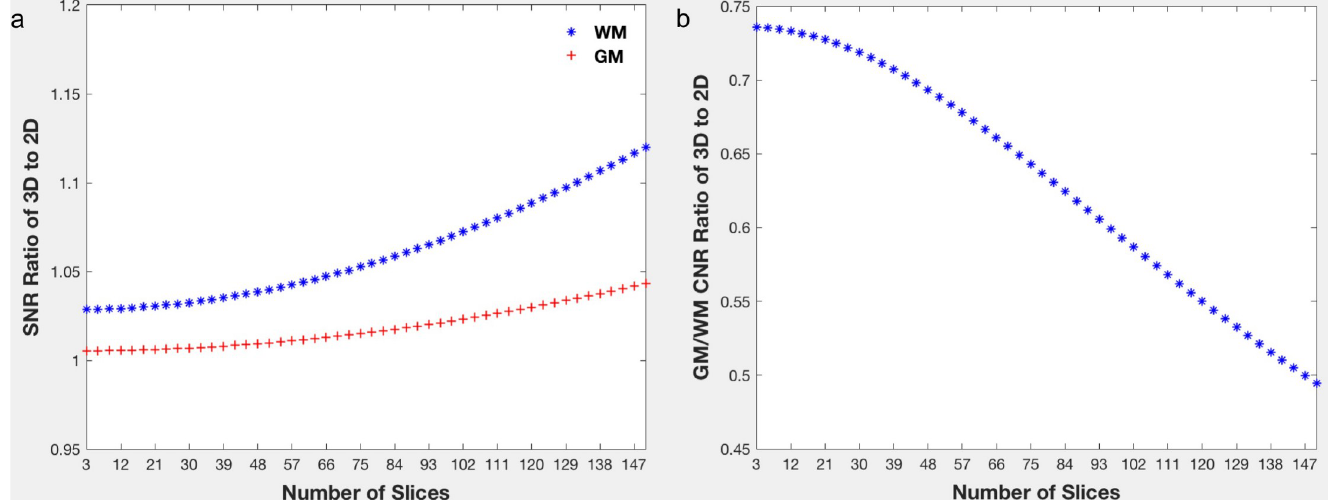
Fig 2. The simulation-derived (a) the SNR ratio of the 3D to the 2D SMS gradient-echo imaging in white and gray matter and (b) the GM/WM CNR ratio using Eqs (5) and (6), respectively, and parameters employed in current study. Note as the slice number increases in the simulation, the TR of 2D imaging also increases accordingly given it is a multiplanar interleaved